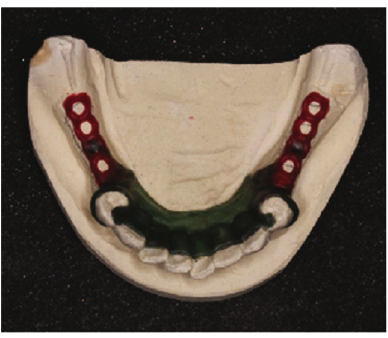
Figure 11: Secondary metal framework.